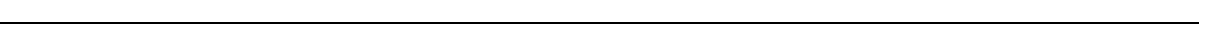
Fig. 4 Heterodimerization of sE-cad with VE-cadherin and the activation of VE-cadherin/ β -catenin signaling cascade. a His-tag pull down assay using sE- cad/Fc (10 μ g mL − 1 ) on Ni-NTA beads and HUVEC lysate (1 mg). b Immunoprecipitation assay using anti-VE-cadherin in HUVEC lysates (1 mg) untreated or treated with exosomes (25 μ g mL − 1 ). Left: Representative western blot images. Right: Densitometry of E-cadherin. c Tube formation assay of HUVEC treated with exosomes (25 μ g mL − 1 ) in the presence or absence of VE-cadherin neutralizing antibodies, BV9 (10 μ g mL − 1 ). Upper: Representative images of HUVEC tube formation assay. Lower: Quanti fi cation of the percentage change of the number of branching points. Bar, 100 μ m. d Subcellular fractionation of HUVEC treated with exosomes (25 μ g mL − 1 ) for 0, 30, or 60 min. Upper: Representative images of nuclear fractions. Lower: Densitometry of β -catenin ( β -cat) and p120 catenin (p120 ctn ). e Subcellular fractionation of HUVEC treated with exosomes (25 μ g mL − 1 ) in the presence of E-cadherin neutralizing antibodies, HECD-1 (100 μ g mL − 1 ) for 60 min. Upper: Representative images of nuclear fractions. Lower: Densitometry of β -catenin ( β -cat) and p120 catenin (p120 ctn ). f Tube formation assay of HUVEC transiently transfected with non-speci fi c (NS) siRNA or β -catenin siRNA (20 nM) for 24 h, treated with exosomes (25 μ g mL − 1 ). Upper: Representative images of HUVEC tube formation assay. Lower: Quanti fi cation of the percentage change of the number of branching points. Representative western blot images of β -catenin knockdown in HUVEC were also included. Bar, 100 μ m. g Subcellular fractionation of HUVEC treated with exosomes (25 μ g mL − 1 ) in the presence of VE-cadherin neutralizing antibodies, BV9 (10 μ g mL − 1 ) for 60 min. Left: Representative images of nuclear fractions. Right: Densitometry of β -catenin ( β -cat) and p120 catenin (p120 ctn ). n = 3 per group, all experiments were repeated three times. Error bar indicates SD of the mean. * P < 0.05 versus untreated control using one-way analysis of variance followed by Tukey ’ s least signi fi cant difference post hoc